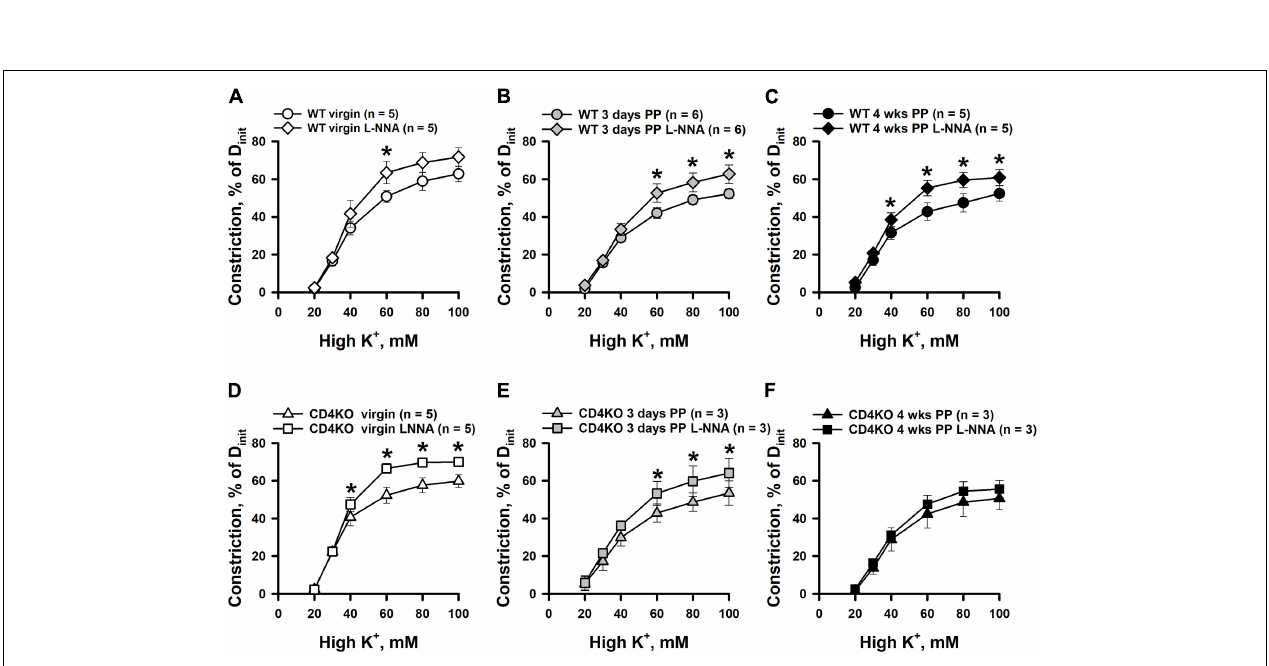
FIGURE 5 | An enhancement of high K + induced constriction of internal carotid arteries (ICAs) from C57BL/6 wild-type (WT) and CD4 T cell deficient (CD4KO) virgin and postpartum (PP) mice after blockade of NO production with L-NNA. (A–C) Summary graphs showing a significant potentiation of high K + induced responses of ICAs from WT mice after inhibition of NOS activity with L-NNA (* P < 0.05, two way RM ANOVA). L-NNA treatment resulted in an increase in high K + -induced constriction in arteries from CD4KO virgin (D) and 3 days (E) PP mice (* P < 0.05, two way RM ANOVA). (F) A summary graph showing unaltered high K + -evoked constriction of arteries from 4 weeks PP vs. virgin CD4KO mice ( P > 0.05, two way ANOVA).